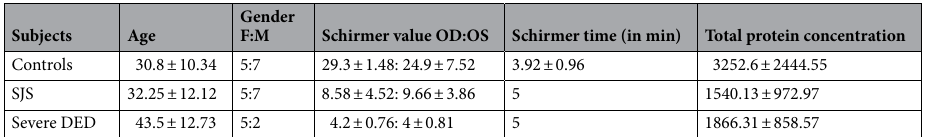
Table 1. The table below shows the age and gender of chronic SJS, healthy controls and severe DED patients. Also the schirmer value and total protein concentration of the collected tears. Also the schirmer value and total protein concentration of the collected